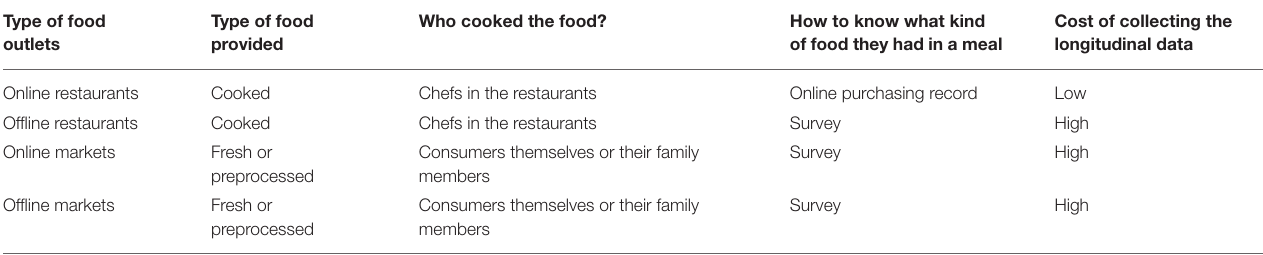
TABLE 1 | Comparison of characteristics of different types of food